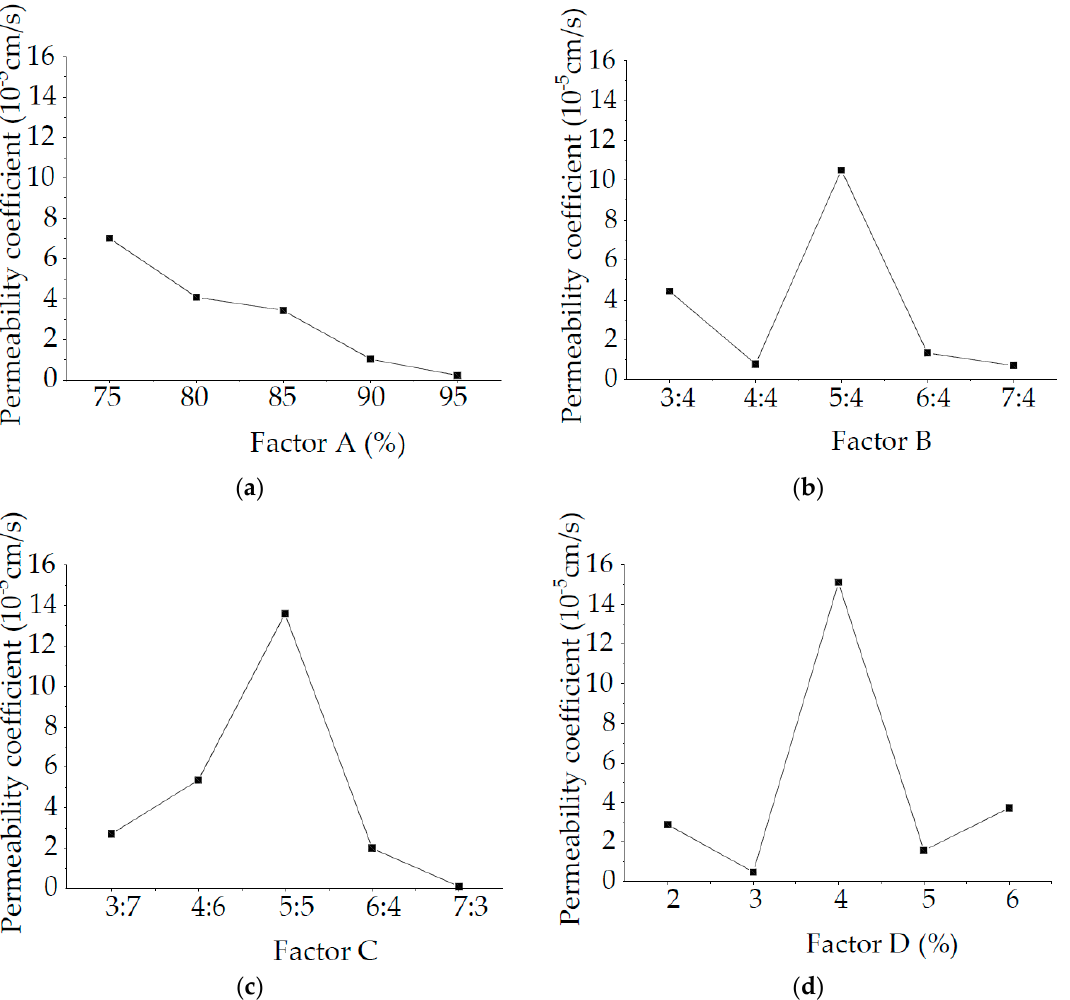
Figure 8. Intuitive analysis chart of permeability coefficient influencing factor: ( a ) Factor A; ( b ) Factor B; ( c ) Factor C; ( d ) Factor D.